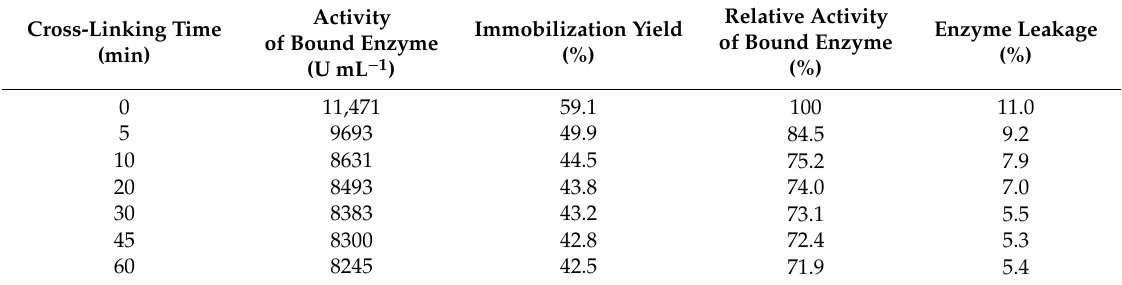
Table 5. E ff ect of the time of cross-linking with 2.0% glutaraldehyde (GA) on invertase immobilization in alginate-based hydrogel.